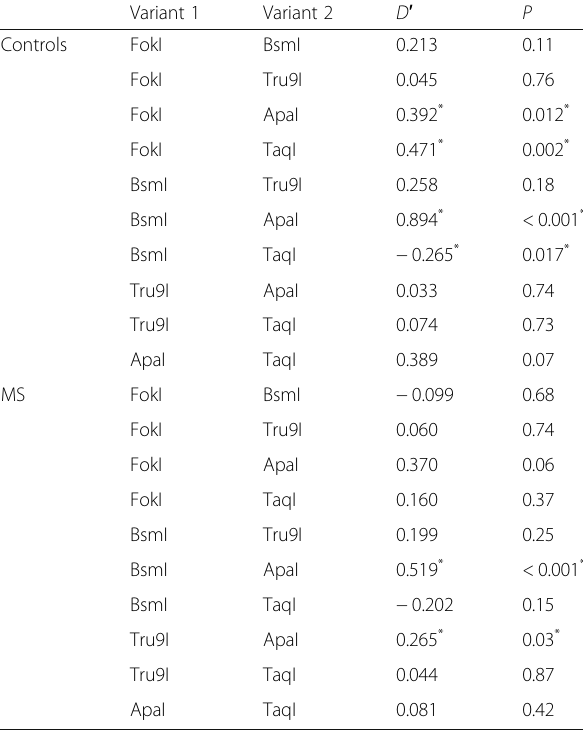
Table 3 Pairwise linkage disequilibrium of VDR gene